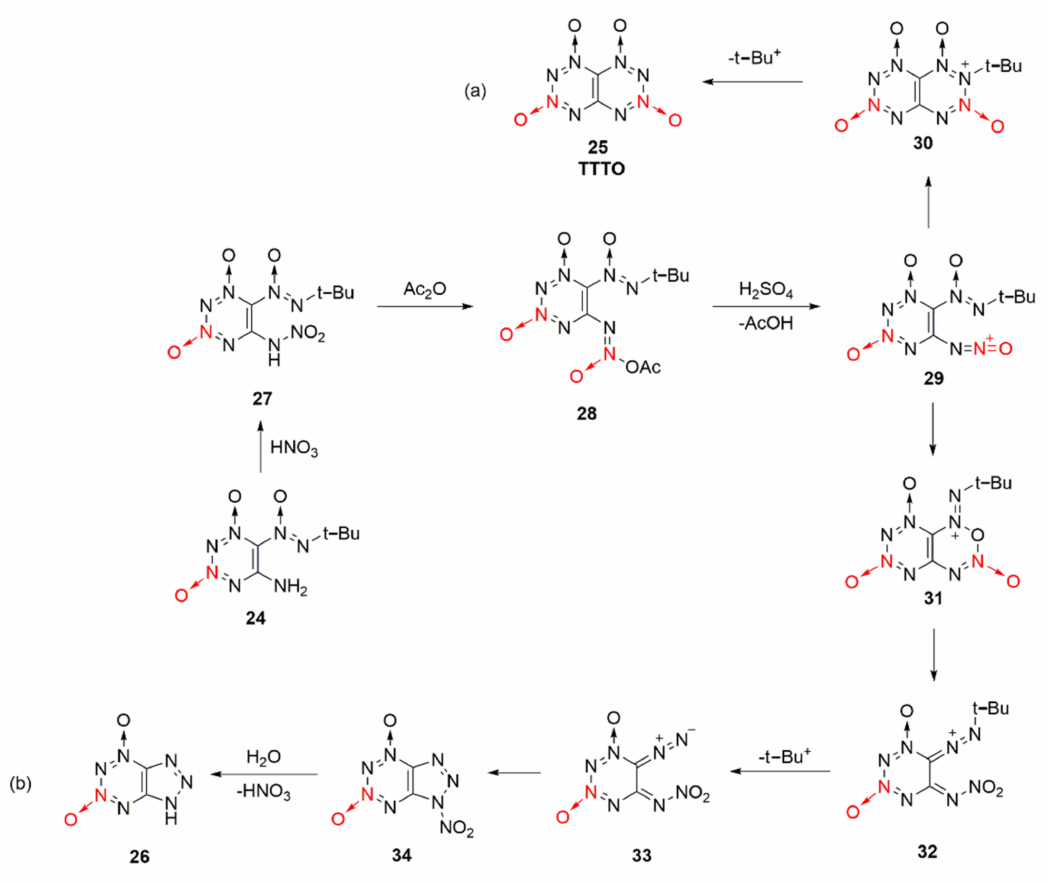
Scheme 5. Possible synthetic routes ( a ) and ( b ) for compound 26 and TTTO